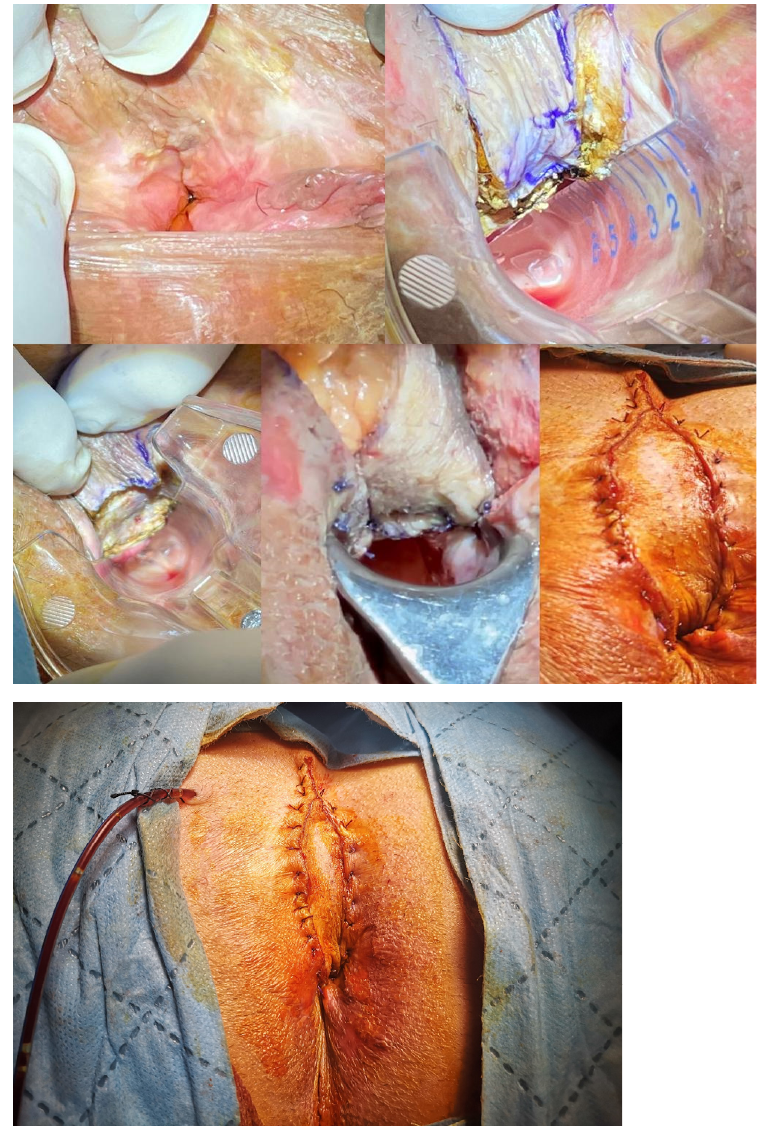
Figure 2. A tailored house flap anoplasty in a patient with chronic unhealing wound in the posterior anal canal.